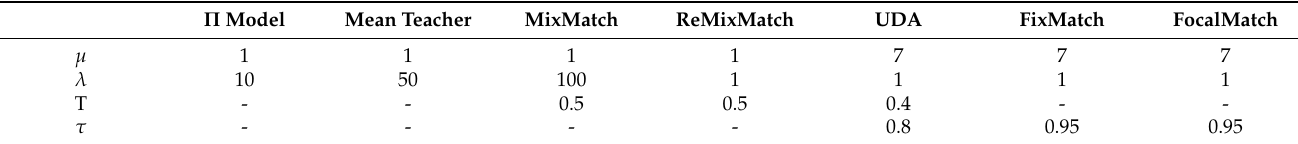
Table A1. Hyperparameters for Different Methods in Table 1 1